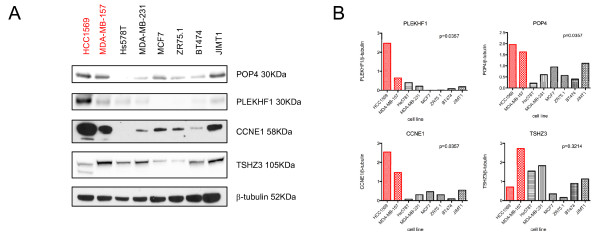
PLEKHF1, POP4, and CCNE1 are overexpressed when amplified at the protein level. (A) Western blot analysis of cell line panel with antibodies against POP4, PLEKHF1, CCNE1 and TSHZ3 in the breast cancer cell lines studied. In red, breast cancer cell lines harbouring amplification of the 19q12 locus. (B) Bar plots depicting POP4, PLEKHF1, CCNE1 and TSHZ3 protein expression quantified relative to the β-tubulin loading control, using ImageJ 1.44p (NIH, USA).